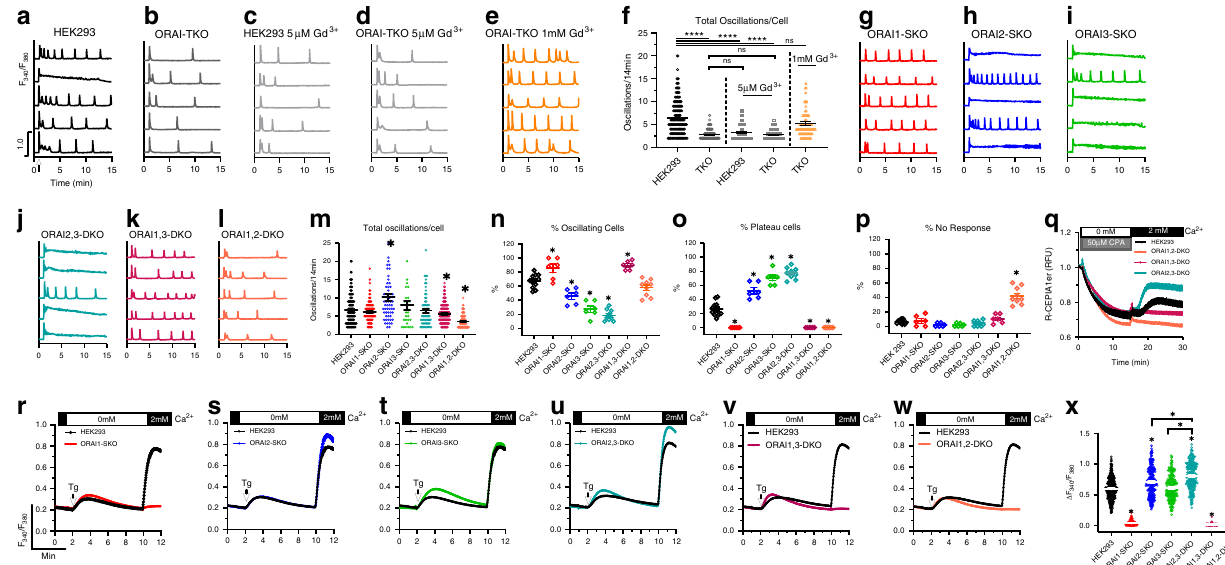
Fig. 1 SOCE but not ORAI1 is required for maintenance of Ca 2 + oscillations. a – e Representative Ca 2 + oscillations in response to 10 µ M carbachol (Cch) measured using Fura2 in wild-type HEK293 and ORAI-TKO cells. Cells were maintained in HBSS containing 2 mM Ca 2 + and stimulated with 10 µ M Cch at 1 min (indicated by arrow in “ a ” ). Representative traces from fi ve cells/condition were chosen to represent the datasets as a whole. In c , d , cells were treated with 5 µ M Gd 3 + to block SOCE. In e , ORAI-TKO cells were treated with 1 mM Gd 3 + (so-called Gd 3 + insulation to block both SOCE and Ca 2 + extrusion). f Quanti fi cation of total oscillations/14 min for all conditions from a – e (from left to right n = 80, 84, 180, 127, and 78; n -values correspond to individual cells). g – l Representative Ca 2 + oscillations in response to 10 µ M Cch measured using Fura2 over the course of 15 min in ORAI single (SKO) and double (DKO) knockout cell clones. m – p Quanti fi cation of total oscillations/14 min ( m ) (from left to right n = 190, 111, 58, 29, 206, 214, and 67; n -values correspond to individual cells), % of oscillating cells ( n ), % of plateau cells (o), and % of non-responding cells ( p ) for data in g – l (for n – p , from left to right n = 12, 6, 6, 6, 9, 6, and 9; n -values correspond to independent experiments). q Direct ER Ca 2 + measurements using CEPIA1 er in parental HEK293 cells and ORAI-DKO cells. r – w Measurements of ER Ca 2 + release (in 0 mM Ca 2 + ) and SOCE (in 2 mM Ca 2 + ) on store depletion with 2 µ M thapsigargin (Tg) in parental HEK293 cells and ORAI-SKO and DKO cells; all traces are plotted as mean ± SEM. x Quanti fi cation of SOCE magnitude for all conditions from r – w . Scatter plots ( f , m , x ) are represented as mean ± SEM and were statistically analyzed using a Kruskal – Wallis one-way ANOVA with multiple comparisons to WT HEK293 where (* p < 0.05, **** p < 0.0001) (from left to right n = 413, 244, 243, 217, 256, 179, and 435; n -values correspond to individual cells). Where indicated, an independent Kruskal – Wallis one-way test was performed comparing ORAI2-3-DKO cells to ORAI2-SKO and ORAI3-SKO cell lines. Scatter plots ( n – p ) are represented as mean ± SEM and were statistically analyzed using an ordinary one-way ANOVA with multiple comparisons to WT HEK293 (* p < cell types (Fig. 1r, x). Surprisingly, however, ORAI1-SKO cells had preserved Ca 2 + oscillations in response to 10 µM Cch, with similar oscillatory frequencies to those of WT HEK293 cells (Fig. 1g, m). Importantly, ORAI1-SKO cells responded exclu- sively with Ca 2 + oscillations, showing no responses in the form of plateaus (Fig. 1o). ORAI1-SKO cells displayed an average of 86% of oscillating cells (Fig. 1n) with 14% of cells showing no response (Fig. 1p). One potential explanation for this paradoxical result is that ORAI2 and/or ORAI3 contribute discrete Ca 2 + entry under low to mid agonist concentrations to support sustained oscilla- tions in ORAI1-SKO cells.